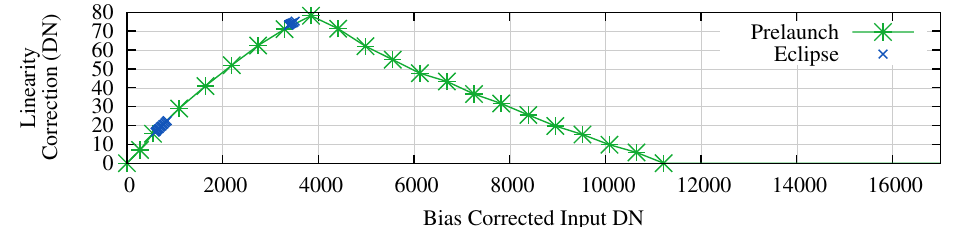
Figure 16. Typical linearity correction curve, with results from on-orbit eclipse collections for the same detector in the green band. This particular detector matches the integration time sweep residuals very